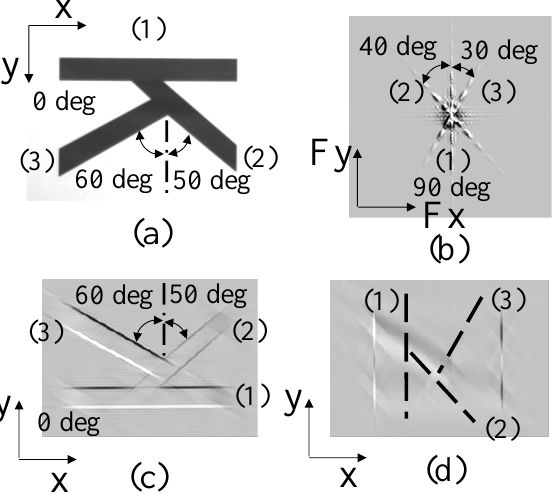
Figure 11. Filters for extracting shape of alphabet character “K”. ( a ) Shape of alphabet character “K” rotated by 90 degree; ( b ) Shape information in frequency domain; ( c ) Character image reconstructed by all parts using each filter; ( d ) Character image reconstructed by passband of filter shown in Figure 10b.